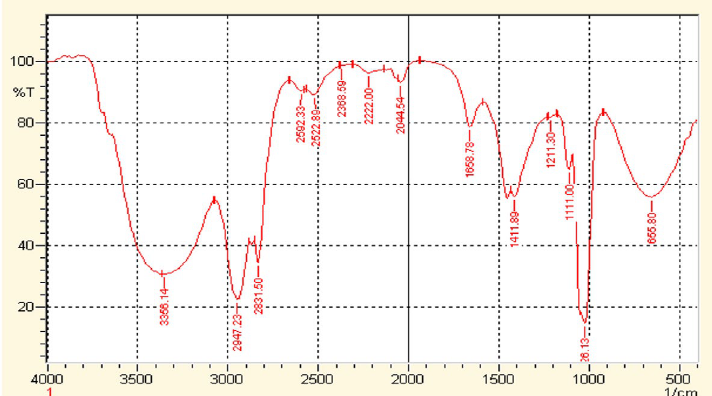
Fig. 2. FTIR spectrum of crude T. ammi Table 3. Antibacterial activity of T. ammi crude extract and AuNPs Microorganism Gram stain